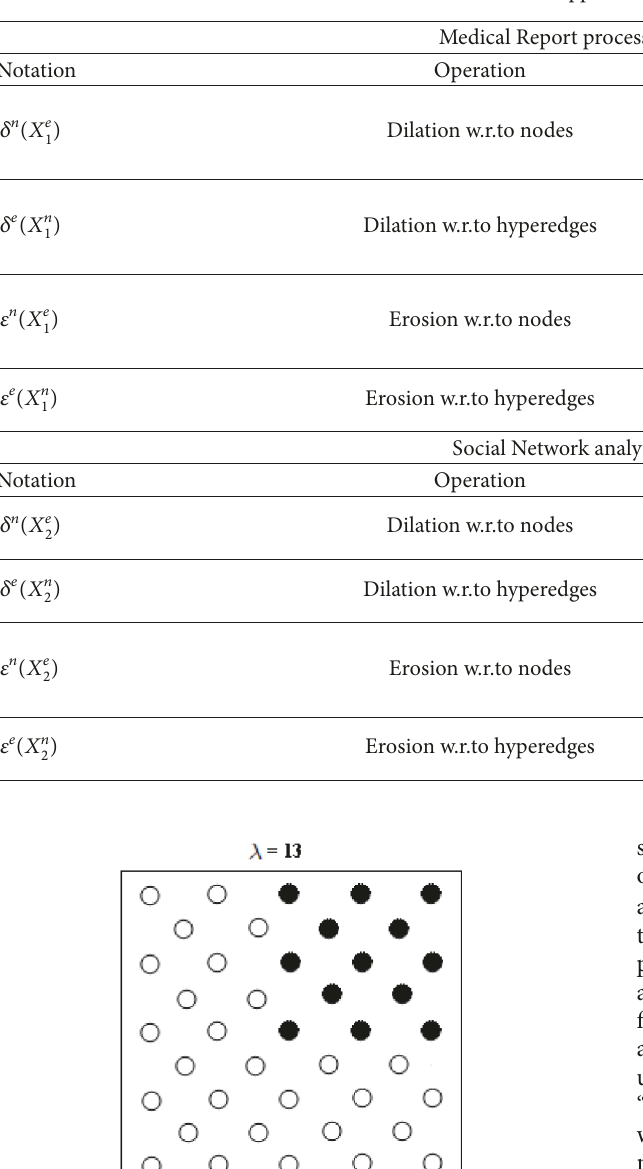
Table 4: Applications of IFHG.